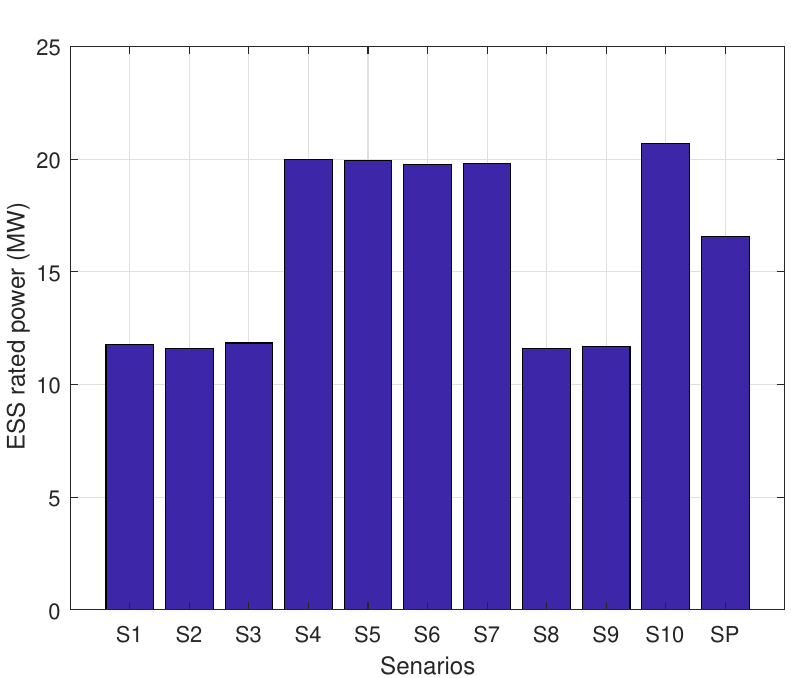
Figure 17. ESS rated power of all